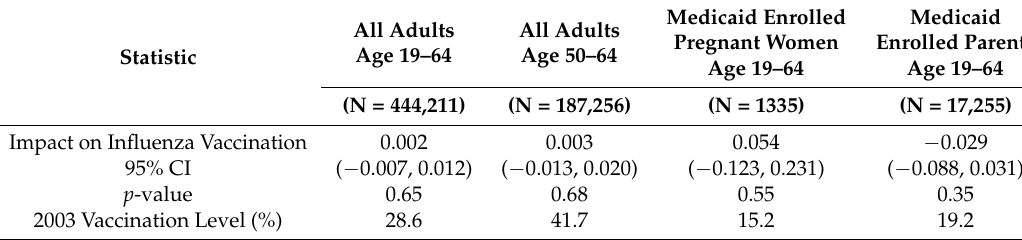
Table 3. Difference-in-difference impacts of prohibiting cost-sharing on influenza vaccination coverage for adults, 2003 vs. 2012 BRFSS data.